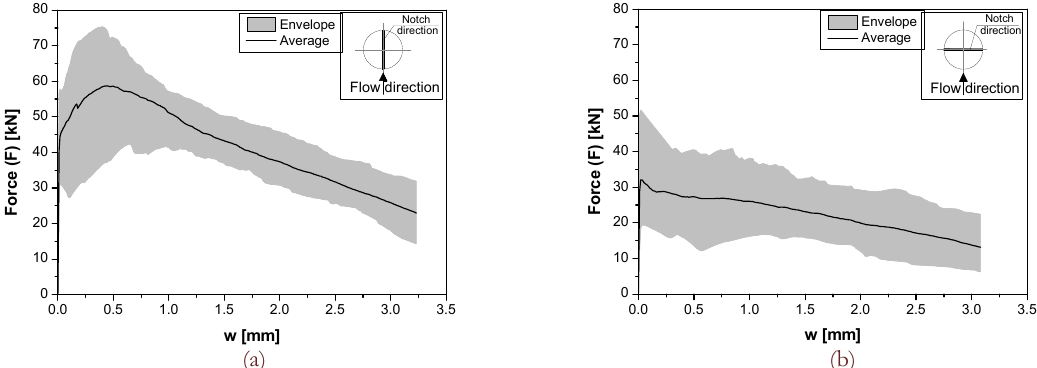
Figure 4: Force – crack opening width relationship, F – w, obtained from splitting tensile test for: (a) θ = 0 ° and (b) θ = 90 ° .